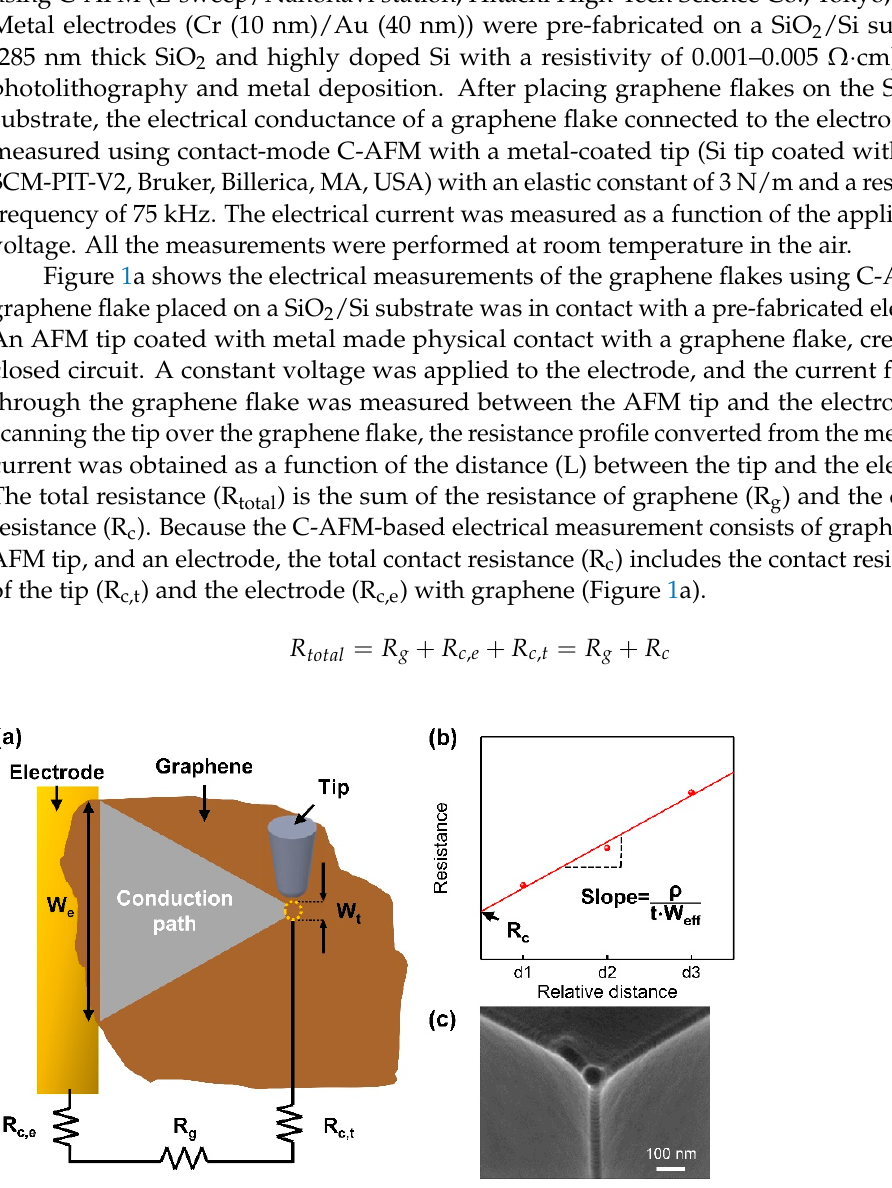
Figure 1. ( a ) Schematic illustration of the electrical measurements of graphene flakes using C-AFM. ( b ) Schematic illustration of the resistance profile as a function of the distance between the tip and the electrode. ( c ) SEM image of the AFM tip.